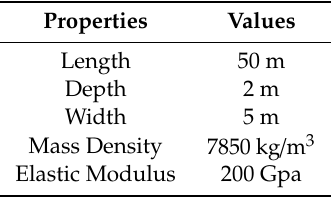
Figure 3. Beam model with a moving load. Table 2. Material properties and dimensions of the beam model.